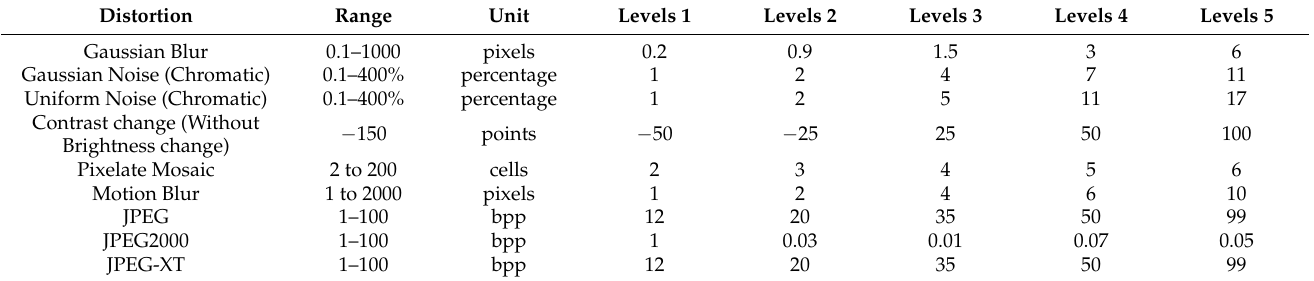
Table 5. Compilation of distortions in the NITS-IQA database in terms of range and level of